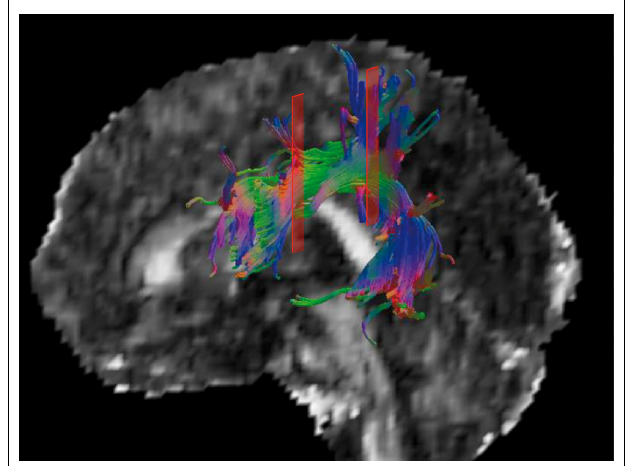
FIGURE 1 | A 3-D model of the left SLF of a single subject is displayed. The red areas indicate the anterior and posterior ROI used for creating the SLF fi bre subset. Only fi bres running through both ROIs are considered to be part of the tracked fi bre structure.